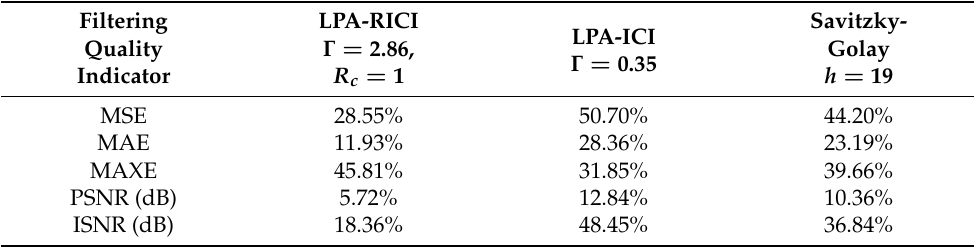
Table 34. Piece-Regular signal (SNR = 10 dB)—Filtering quality improvement of the RBF-RICI-based filtering over other tested